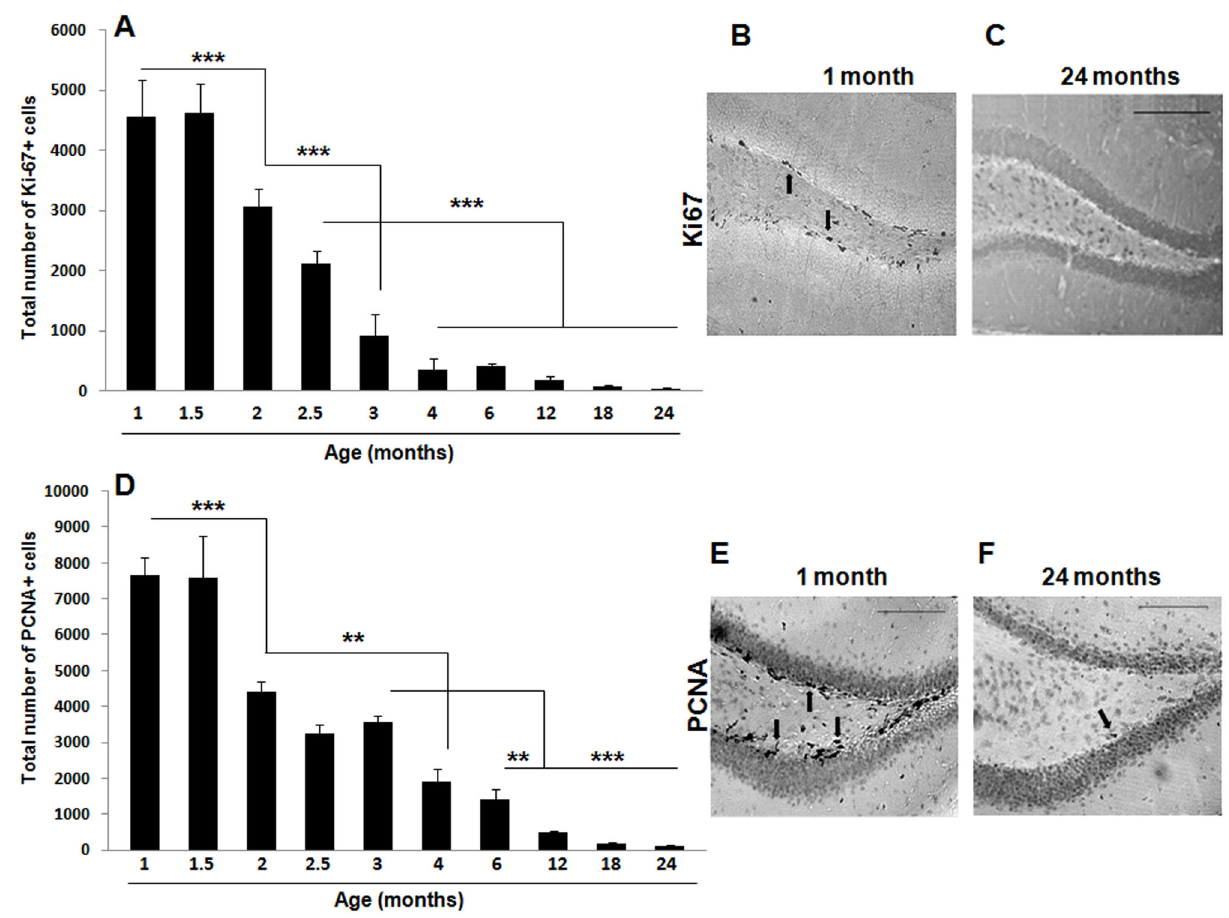
Figure 2. Cell proliferation is significantly decreased by age in the mouse hippocampal DG. POMC-EGFP transgenic mice were sacrificed at 1, 1.5, 2, 2.5, 3, 4, 6, 12, 18, 24 months of age by transcardial perfusion and their brains were processed for immunohistochemistry for the endogenous cell proliferation markers Ki-67 (A-C) and PCNA (D-F). Age induced a significant decline in the expression of both Ki-67 (A-C) and PCNA (D-F). An abrupt reduction in cell proliferation was detected early on (between 1.5 and 3 months of age) with both markers. Data are presented as means ± SEM. (A) *** p < 0.001 between 1 or 1.5 and 2 months, between 2 and 3 months, and between 2.5 and 4, 6, 12, 18 or 24 months. (D) ** p < 0.01 between 2 and 4 months, and between 3 and 6 months, *** p < 0.001 between 1 or 1.5 and 2 months, and between 3 and 12, 18, or 24 months. See text for additional statistical details. Representative sections of the DG processed for Ki-67 (B, C) and PCNA (E, F) immunohistochemistry in 1- (B, E) and 24- (C, F) month old POMC-EGFP mice. Black arrows indicate either Ki-67- (B) or PCNA- (E, F) immunopositive cells in the DG of 1- (B, E) and 24- (F) month old mice. Scale bars = 100